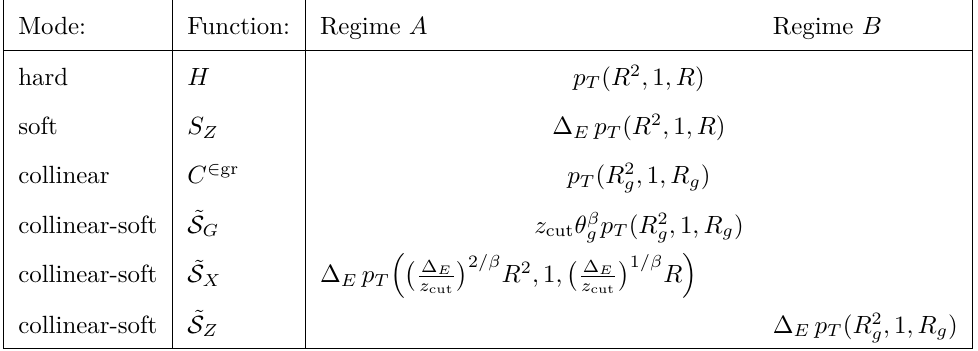
Table 3 . The scaling of the modes that enter the factorization formulae of the jet energy drop cross section in the kinematic region where ∆ E (cid:28) z cut (cid:28) 1 and θ g = R g /R (cid:28) 1 . Regime A ( B ) correspond to θ g being smaller (larger) than (∆ E /z cut ) 1 /β